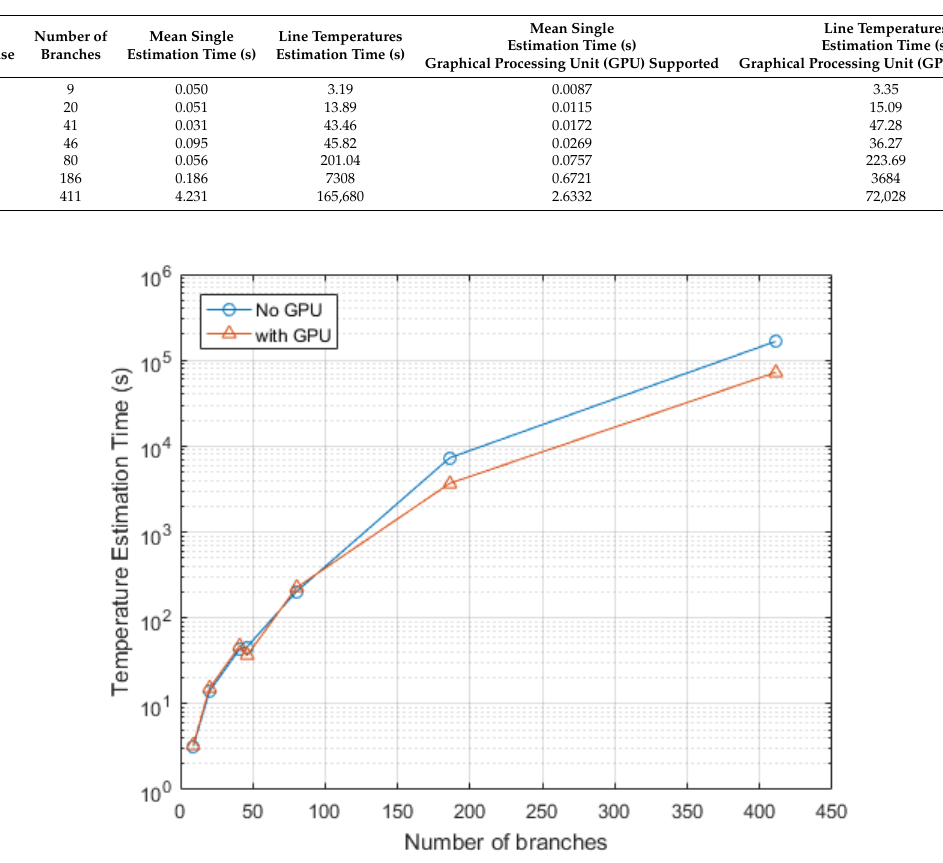
Figure 5. Line temperatures estimation time as a function of increasing branch number in the power system